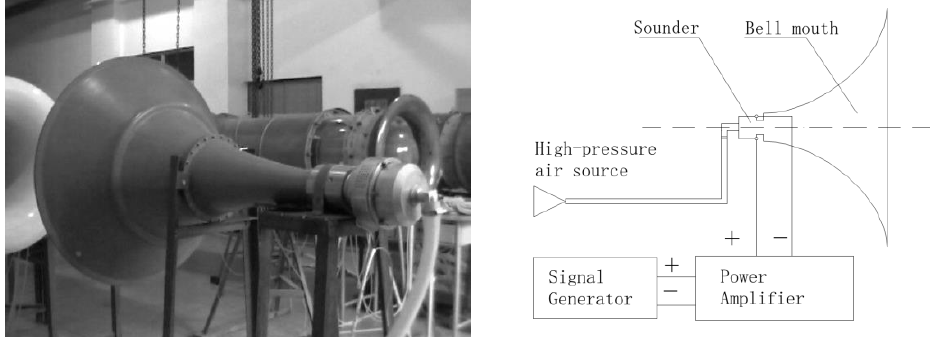
Figure 3. The schematic plot of the sound generator in the experiment.